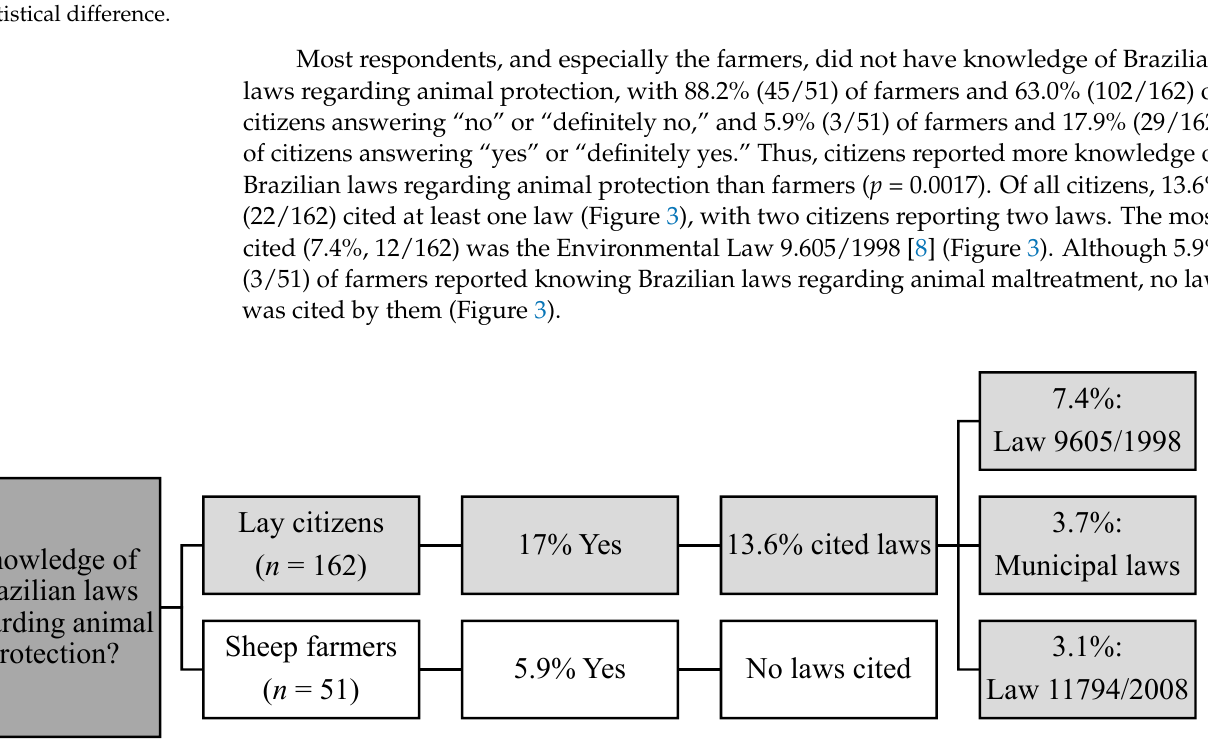
statistical difference.